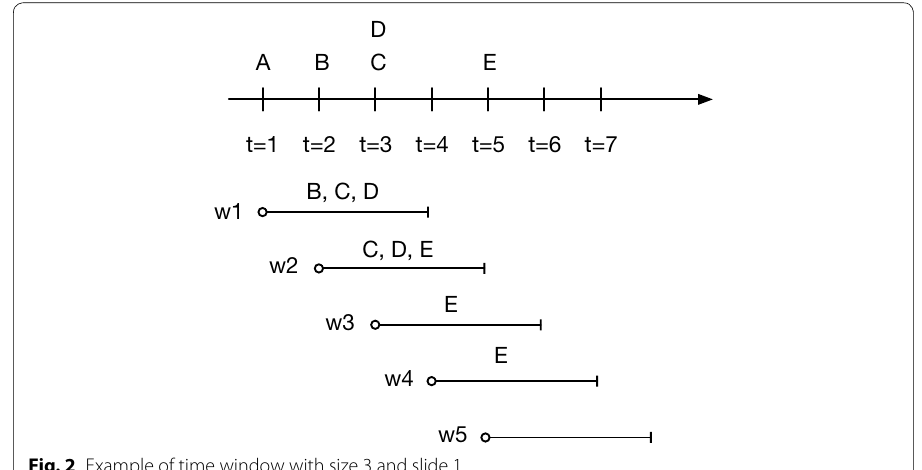
Fig. 2 Example of time window with size 3 and slide